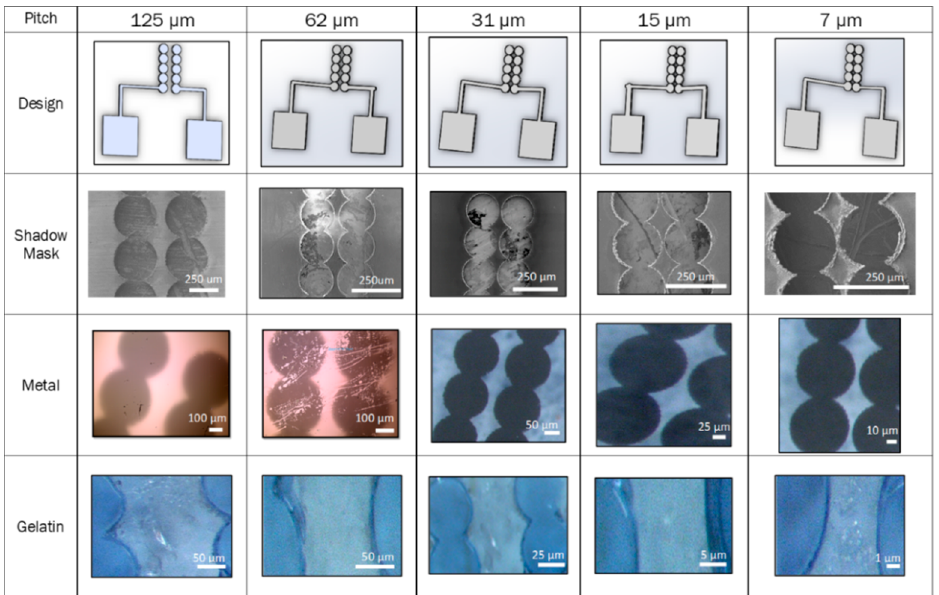
Figure 12. Results of laser micromachining of the shadow masks, as well as inorganic and organic layer patterning. The design of an interdigitated electrode (IDE) was translated into metal (titanium-gold) and bioink (gelatin).